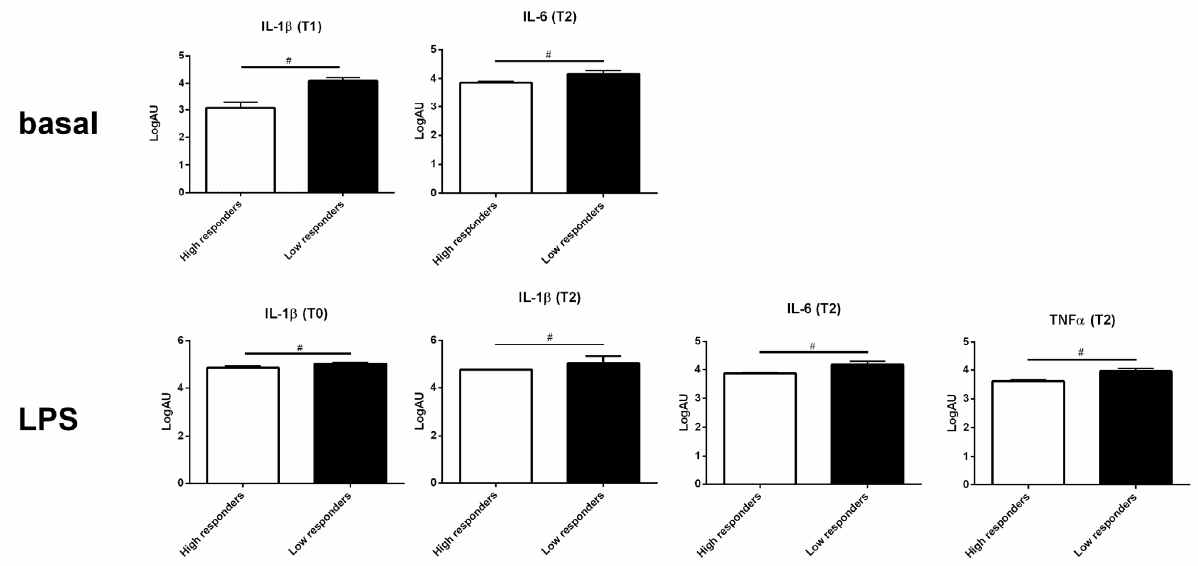
Figure 5. Different responses of PBMCs from high and low responders. PBMCs of high (white bars) and low (black bars) responders expressed different levels of proinflammatory cytokines under basal conditions and after LPS stimulation at different time points (T0 = 15 days before calving; T1 = 7 days post-calving, T2 = 21 days post-calving). Gene expression was analyzed by RT qPCR. Only the graphs of cytokine expression with p < 0.1 or p < 0.05 are reported. Values are median and Q1 and Q3. # p < 0.1.